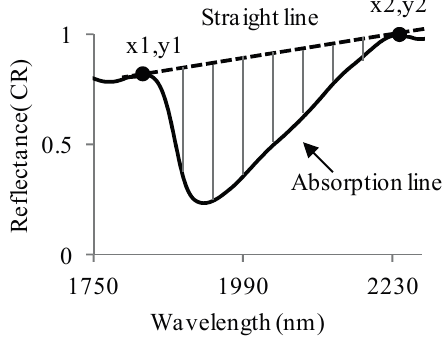
Figure 1. Demonstration of absorption area